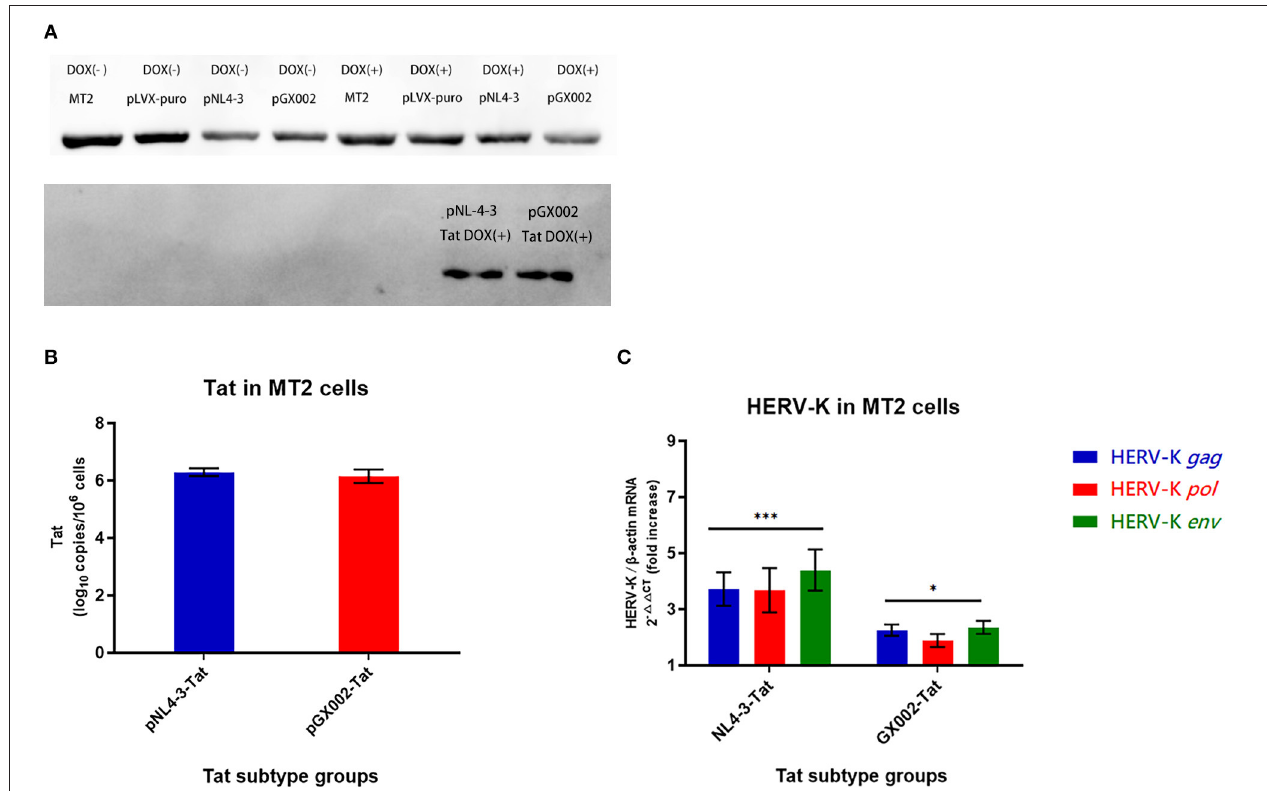
FIGURE 5 | (A) pNL4-3 and pGX002 in the DOX( + ) groups expressed large amounts of Tat protein; MT2 cells in the uninfected group and the blank plasmid-transfected group DOX( + ) did not express Tat protein; all MT2 cells in the DOX(-) groups did not express Tat protein. (B) Red represents the pGX002 group, blue represents the pNL4-3 group. The Y-axis represents log 10 of the Tat gene load, and the units are indicated in the title of the Y-axis. Standard errors for triplicate experiments are indicated. (C) Blue represents HERV-K gag , red represents HERV-K pol , green represents HERV-K env . The X-axis is Tat subtype groups. The Y-axis shows the fold increase in transcription level in the HERV-K gag, pol , env region calculated by the 2 − 11 CT method. Standard errors for triplicate experiments are indicated. * P < 0.05, ** P < 0.01, *** P <